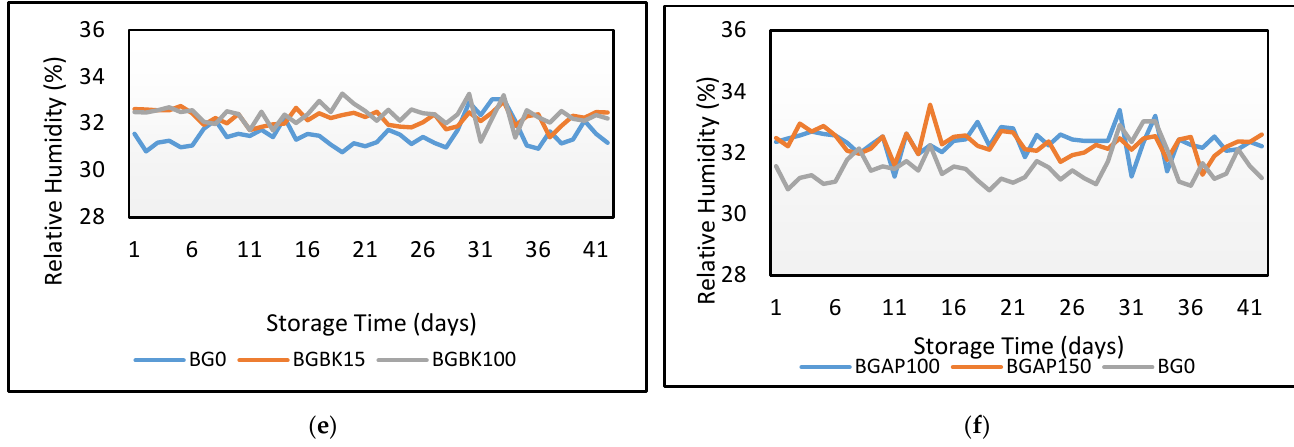
Figure 6. Relative humidity of different storage methods and treatments. ( a ) Breadfruit stored in the silo and treated with aligator pepper. ( b ) Breadfruit stored in the silo and treated with bitter kola. ( c ) Breadfruit stored in the rubber and treated with aligator pepper. ( d ) Breadfruit stored in the rubber and treated with bitter kola. ( e ) Breadfruit stored in the bag and treated with aligator pepper. ( f ) Breadfruit stored in the bag and treated with bitter kola.